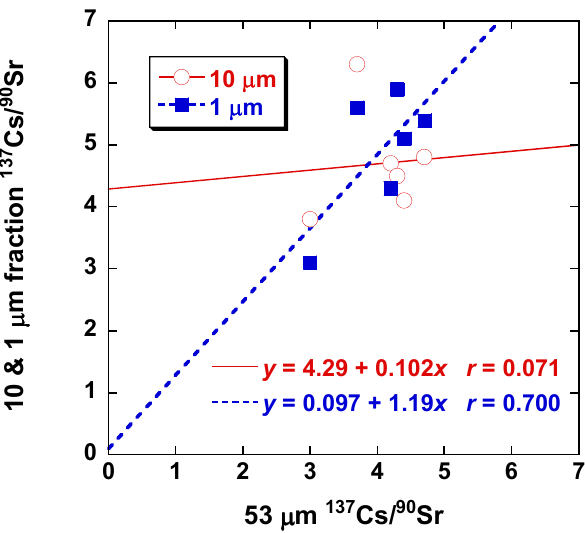
Fig. B1. Correlations of the 137 Cs/ 90 Sr activity ratio in the silt (10-µm) and clay–silt (1-µm) fractions of the Mongolian surface soil samples with the 53-µm fraction from the same sample.